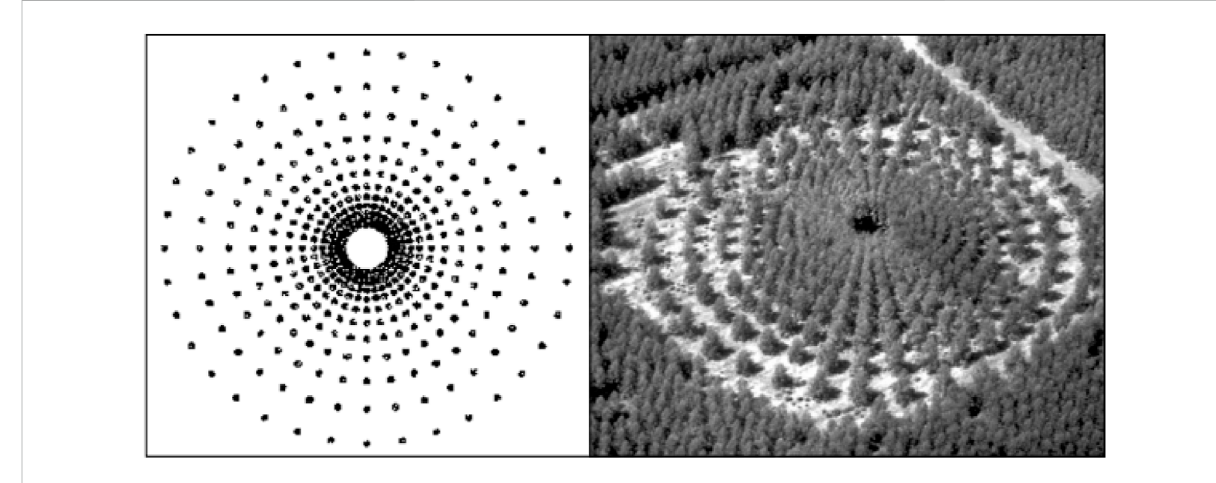
FIGURE 6 Diagramatic representation and photograph of a Nelder planting design with 36 rays and 12